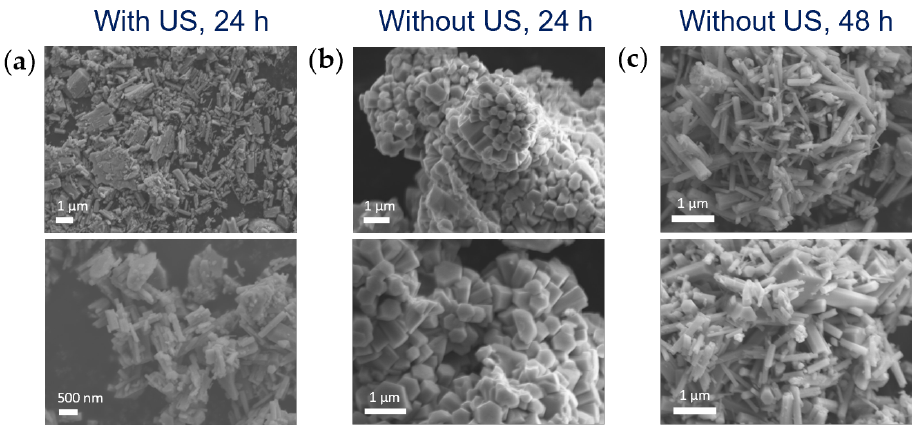
Figure 5. SEM images of ME samples synthesized by ( a ) applying or ( b , c ) not applying US after acid addition and running the reaction for ( a , b ) 24 h or ( c ) 48 h. [AHM] = 0.20 M; AHM: HNO 3 1:20 mol.